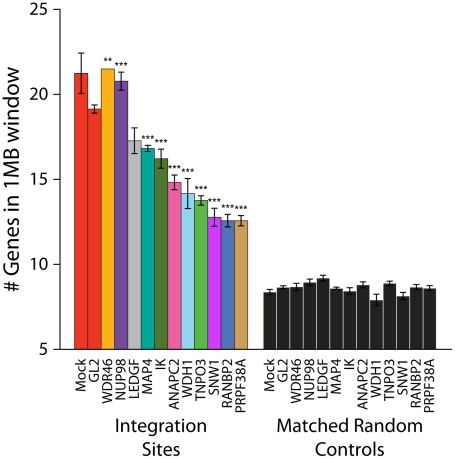
Depletion of additional host factors and their effects on HIV integration in gene dense regions.Integration sites were isolated from cells treated with siRNAs targeting the indicated genes. The average numbers of RefSeq genes in 1 Mb windows surrounding integration sites are shown. Data for a given gene knockdown is the average over multiple siRNA knockdowns using different siRNAs and pools of siRNAs targeted to the same gene, except for Mock, control siRNA (GL2), and LEDGF knockdown conditions for which single treatments were used. Asterisks denote significant difference from control GL2 siRNA-treated cells as determined by the Mann–Whitney test (*P<0.05; **P<0.01; ***P<0.001). Error bars represent standard error for biological replicates. For LEDGF only one dataset was available.